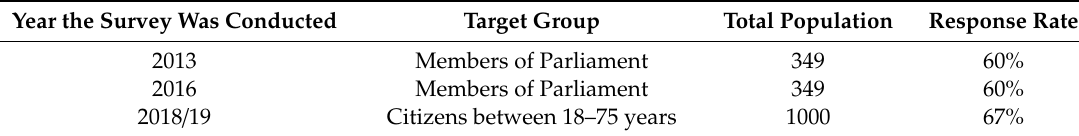
Table 1. The three surveys with target groups and response